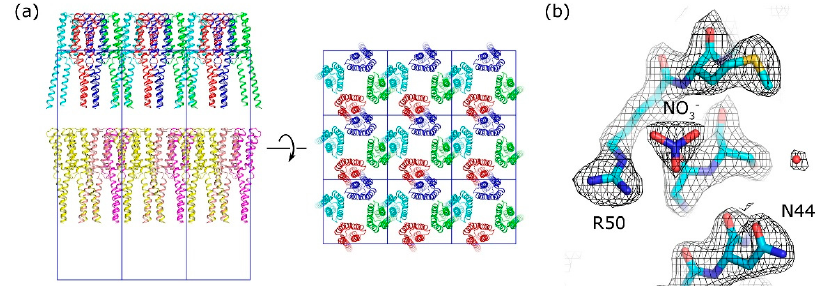
Figure 1. ( a ) Packing of the proteolytic fragment of NarQ in crystals in the space group I4. Symmetry-related molecules are colored differently. The proteins pack in parallel in layers. The remaining space between the protein layers was not sufficient to accommodate the missing HAMP domains. ( b ) An example of the 2F o ‐ F c electron density contoured at the 1.5 × r.m.s.